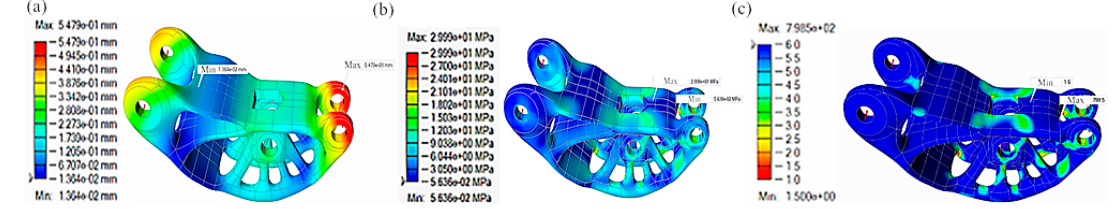
Figure 6. Strength analysis of shock-absorbing-bearing parts: ( a ) Displacement nephogram; ( b ) Stress nephogram; and ( c ) Safety factor.